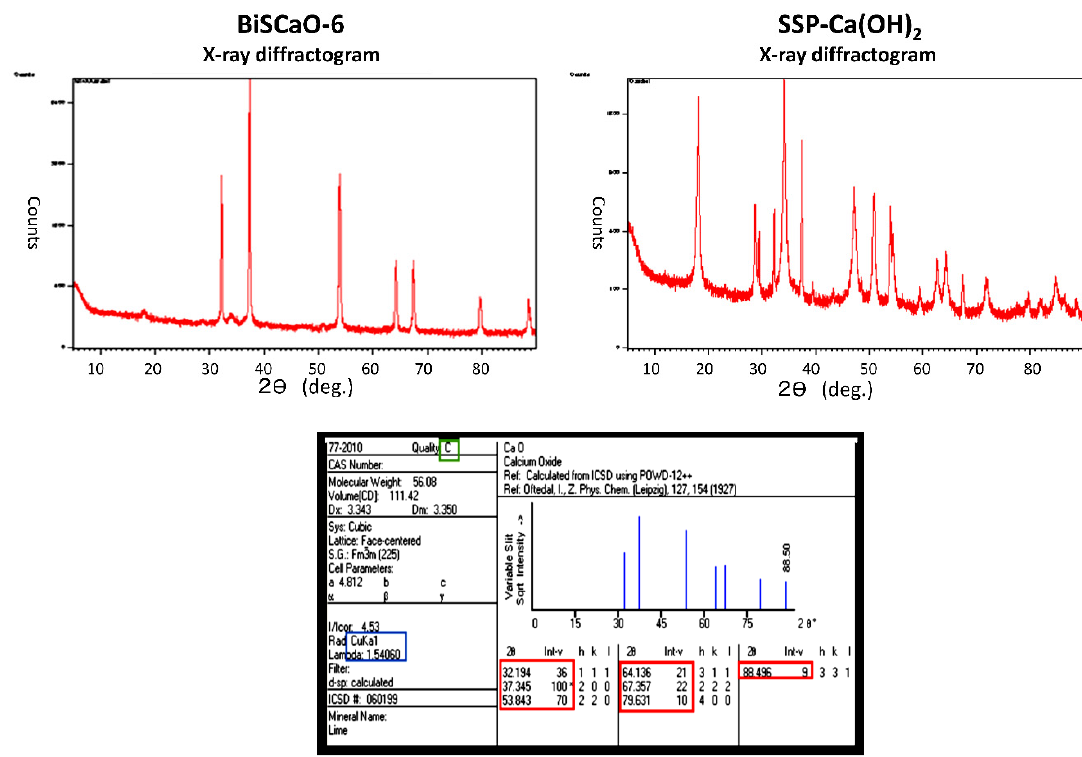
Figure 7. The contents of CaO and Ca(OH) 2 in BiSCaO ‐ 6 and SSP ‐ Ca(OH) 2 were determined using X ‐ ray diffractogram Contents of CaO in BiSCaO ‐ 6 and SSP ‐ Ca(OH) 2 was estimated 99.6% and <10%,